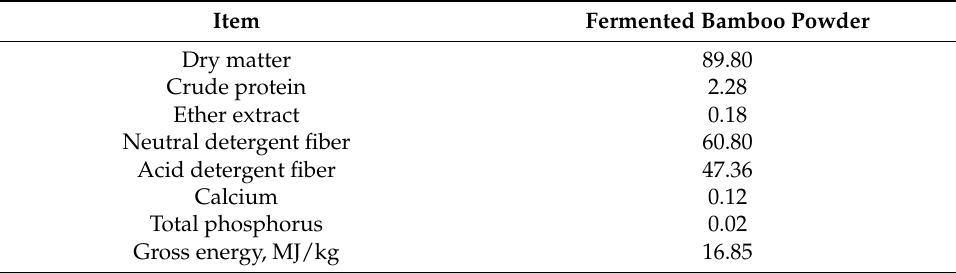
Table 1. Analyzed composition of the fermented bamboo powder (%, as-fed